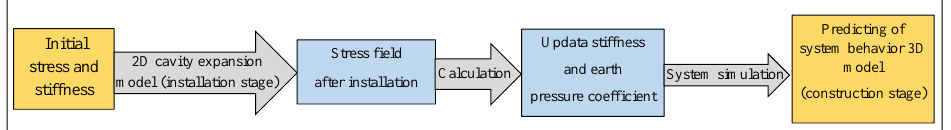
Figure 1. Steps adopted to calculate the stress state and the stiffness in this